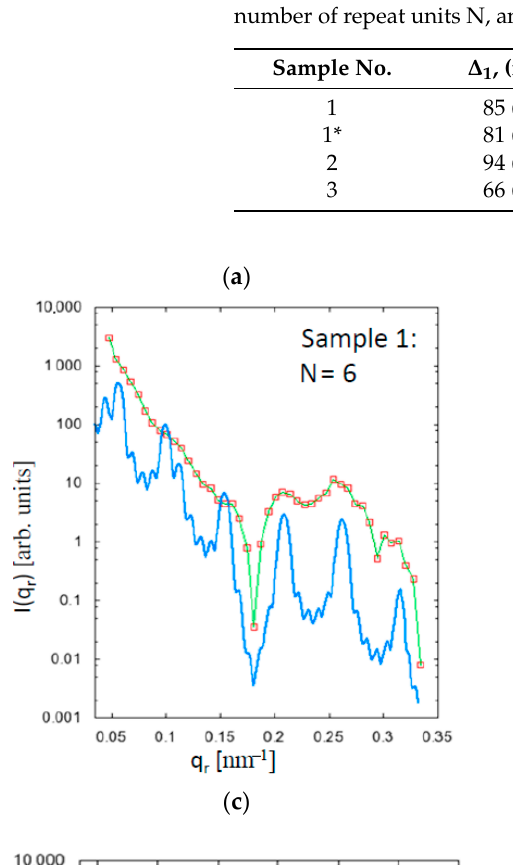
Figure 4. Analysis of the meridional scattering contributions using the Guinier fit for sample 1 ( a ), sample 1* ( b ), sample 2 ( c ) and sample 3 ( d ). The meridional dimensions depend, as expected, on both the spin-draw ratio and the